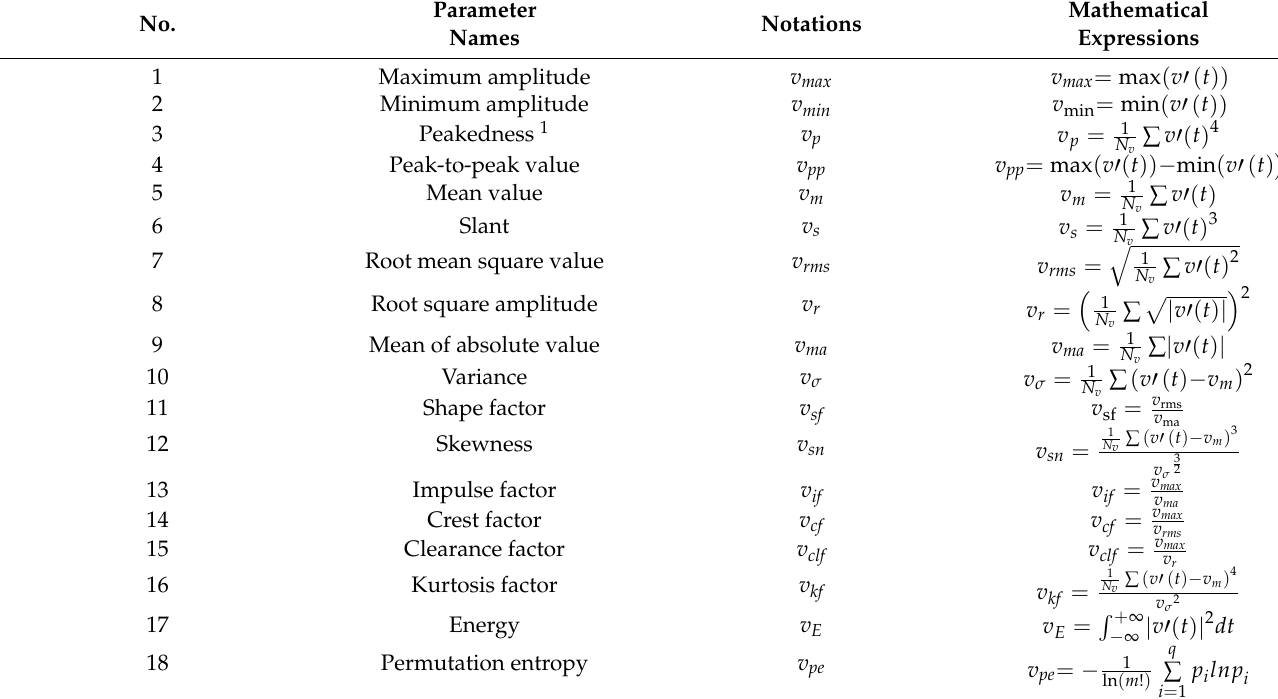
Table 2. List of the 18 feature